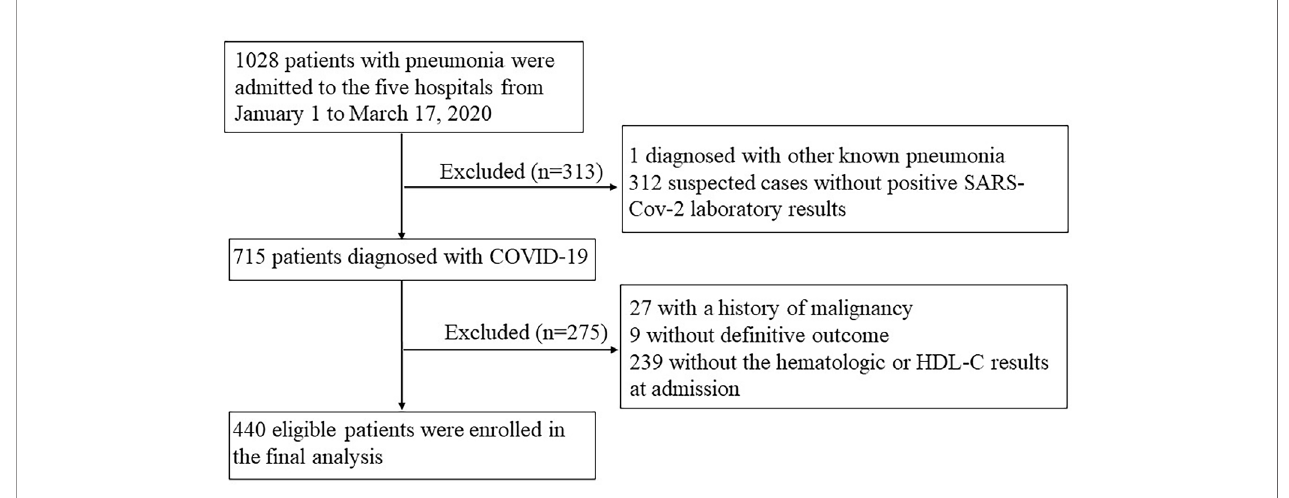
FIGURE 1 | Flow diagram showing the patient selection process.